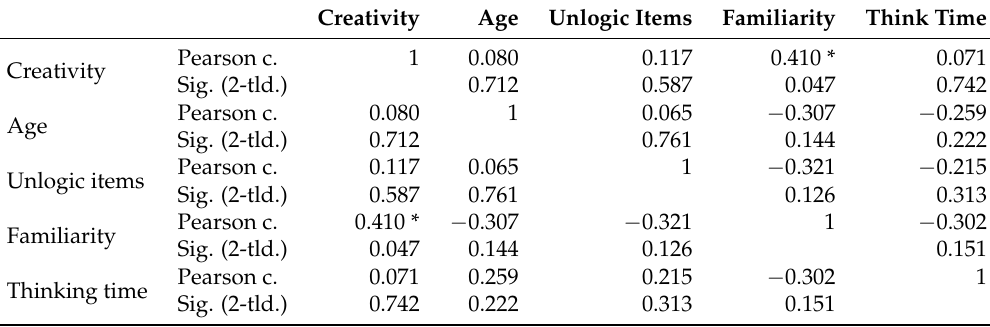
Table 2. Correlations between variables. (*) represents the correlation value between creativity and familiarity with devices among all possible